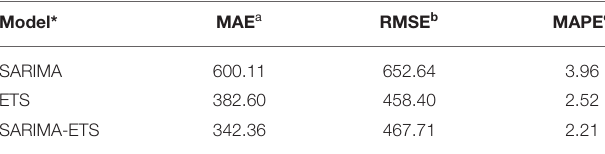
TABLE 1 | Error matrices for time series and hybrid models applied to the validation dataset.